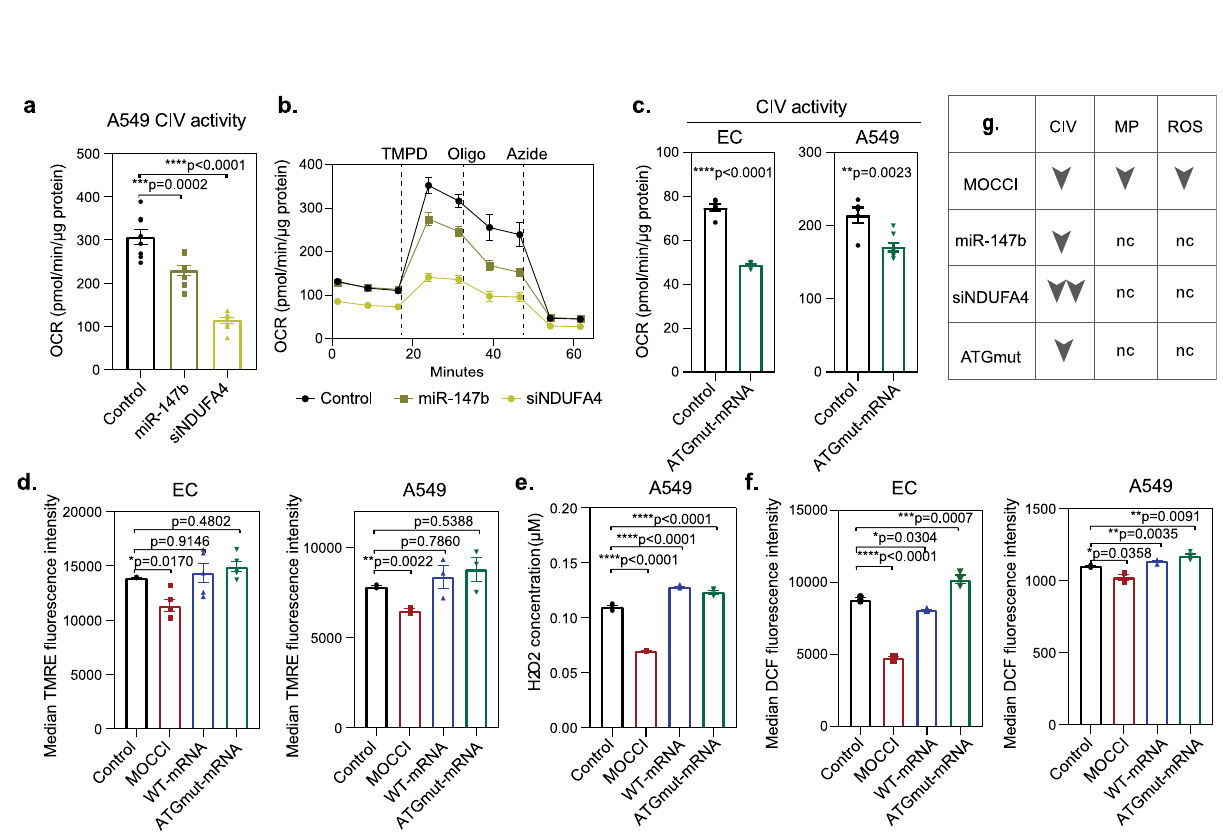
Fig. 6 miR-147b reduces CIV activity but not membrane potential and ROS production. a CIV activity of permeabilized A549 cells transfected with miR- control , miR-147b mimic, or siNDUFA4 as measured by Seahorse. Data were presented as mean ± SEM; P = one-way ANOVA; n = 8 technical replicates per condition. b Seahorse uncoupled electron fl ow analysis of CIV activity in permeabilized A549 cells transfected with miR- control, miR-147b mimic, or siNDUFA4 , as shown in ( a ). Oxygen consumption rate (OCR) reads were normalized with protein levels quanti fi ed with BCA. Dotted line shows the compounds injected at each time point. CIV activity was measured as activity between the maximal activity after TMPD addition and the minimal activity after azide injection. AA antimycin A, TMPD N , N , N ′ , N ′ -Tetramethyl- p -phenylenediamine dihydrochloride, Oligo oligomycin. Data were presented as mean and SEM of eight biological replicates. c CIV activity of permeabilized WT or ATGmut-mRNA overexpressing- HAECs and A549 cells, as measured by Seahorse. Data were presented as mean ± SEM; P = two-tailed unpaired Student ’ s t test; n = 8 technical replicates per condition. d Membrane potential of HAECs and A549 cells with indicated transgenes as measured by fl ow cytometry of TMRE dye incorporation. Data were presented as mean ± SEM; P = one-way ANOVA; n = 4 biological replicates per condition from two repeats. e Total cellular ROS levels of A549 cells with indicated transgenes as measured by Amplex Red assay. Data were presented as mean ± SEM; P = one-way ANOVA; n = 4 biological replicates per condition. Data for control and MOCCI were shown in Fig. 5g. f Total cellular ROS levels of HAECs and A549 cells with indicated transgene as measured by fl ow cytometry of DCF dye reaction. Data were presented as mean ± SEM; P = one-way ANOVA; n = 3 biological replicates per condition. g Effects of MOCCI, miR-147b mimic, siNDUFA4, and ATGmut-mRNA on CIV activity, membrane potential (MP), and ROS